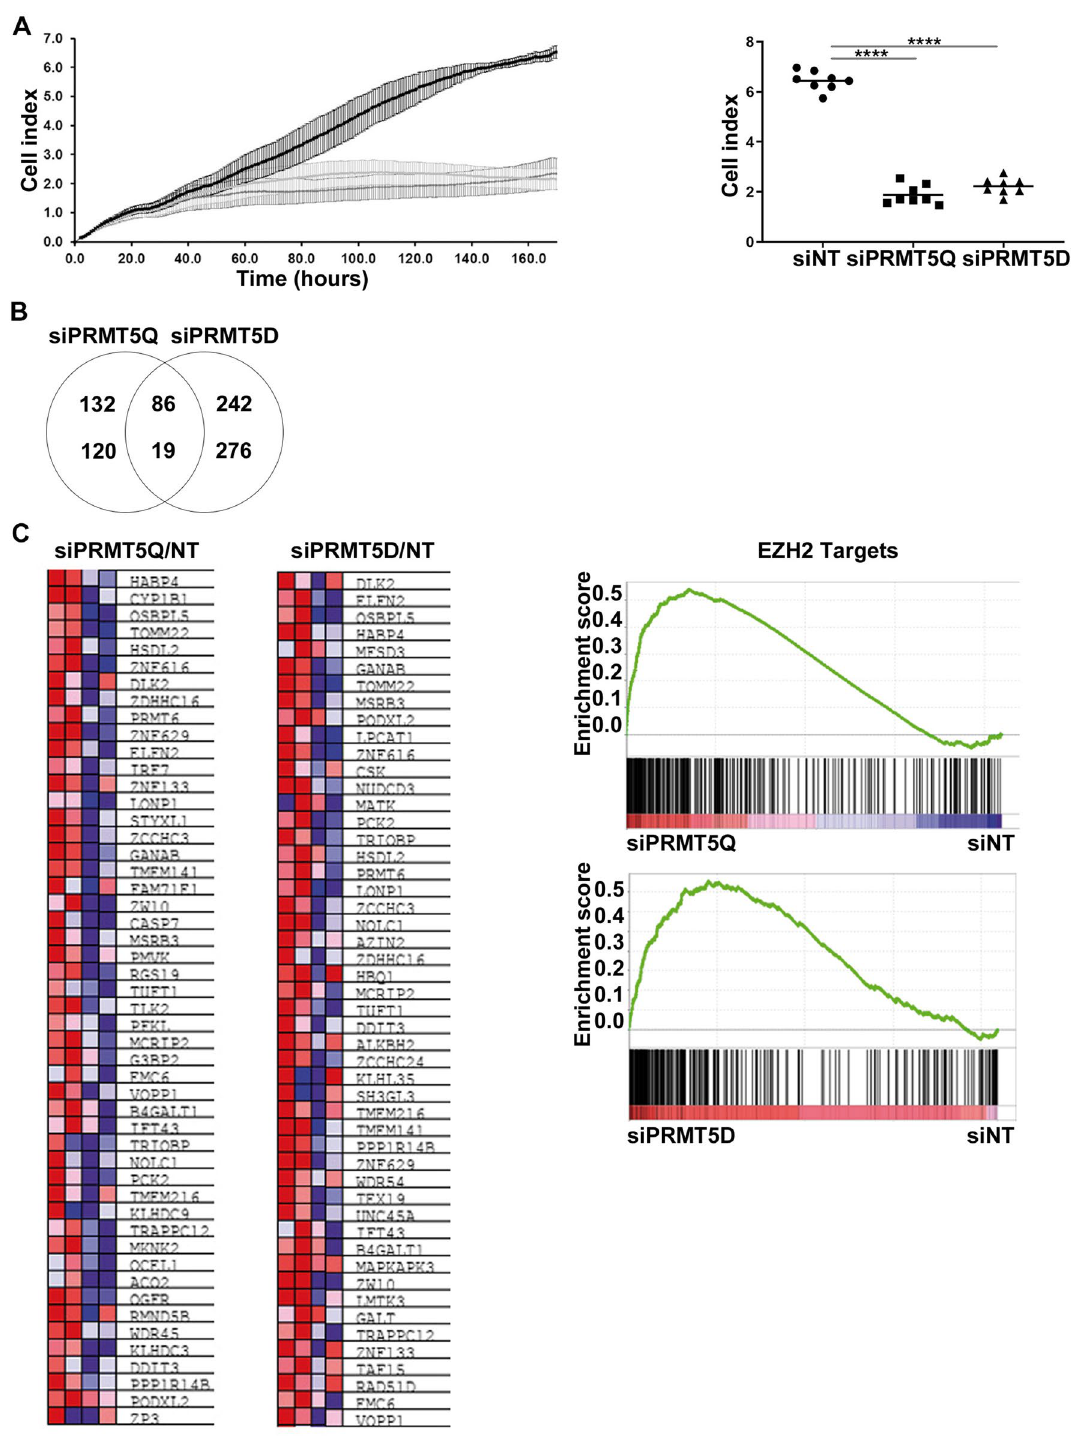
Figure 2. PRMT5 silencing mediates growth arrest in MTAP negative mesothelioma. ( A ) NCI-H2591 cells were transfected with siNT or siPRMT5 (Q: qiagen sequence, D: Dharmacon sequence) 20 nM. Cell proliferation was measured for 168 h with the excelligence real-time cell analyser. Data were normalized to siNT controls (Q p = 0.0015 D p = 0.0019). ( B ) Venn diagram showing upregulated and downregulated genes comparing the PRMT5 siRNAs versus siNT. ( C ) Heatmaps and representative GSEA plots showing a significantly enriched up regulated signatures (siPRMT5 vs.